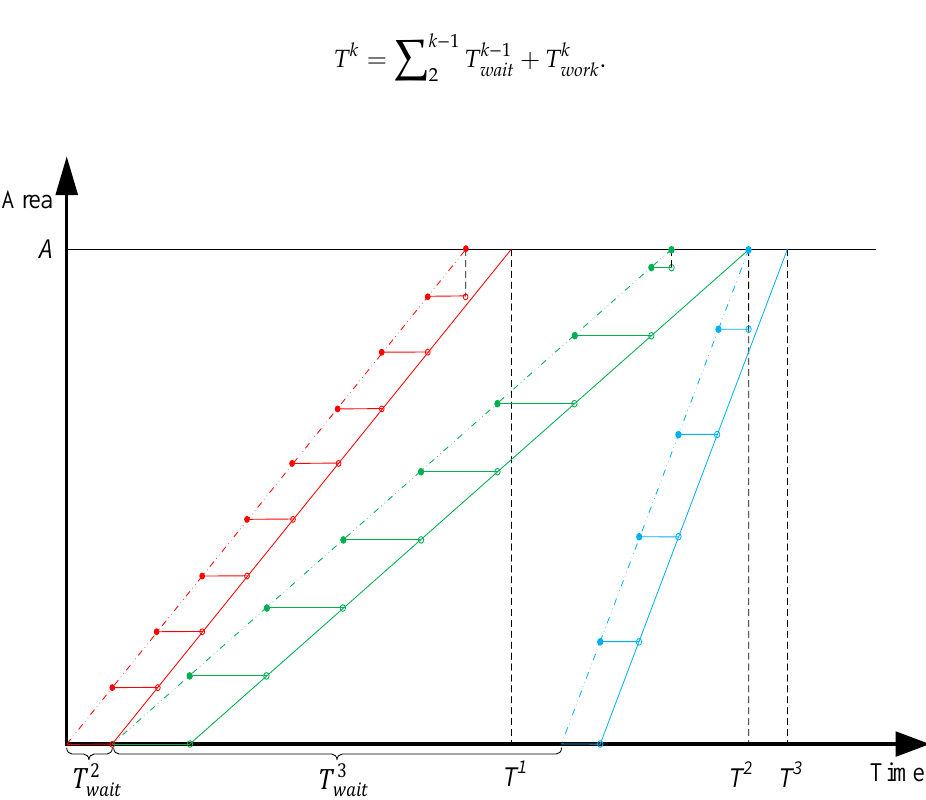
Figure 6. The relationship between the waiting time and the operating capacity per unit time.